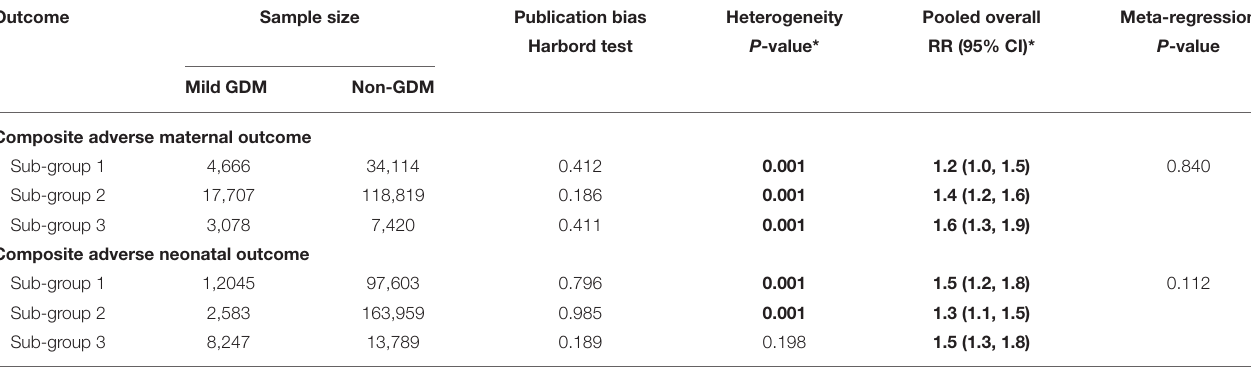
TABLE 3 | Results of heterogeneity, estimation of publication bias, and meta-analysis for comparing the relative risk of adverse maternal and neonatal outcomes based on diagnostic criteria.